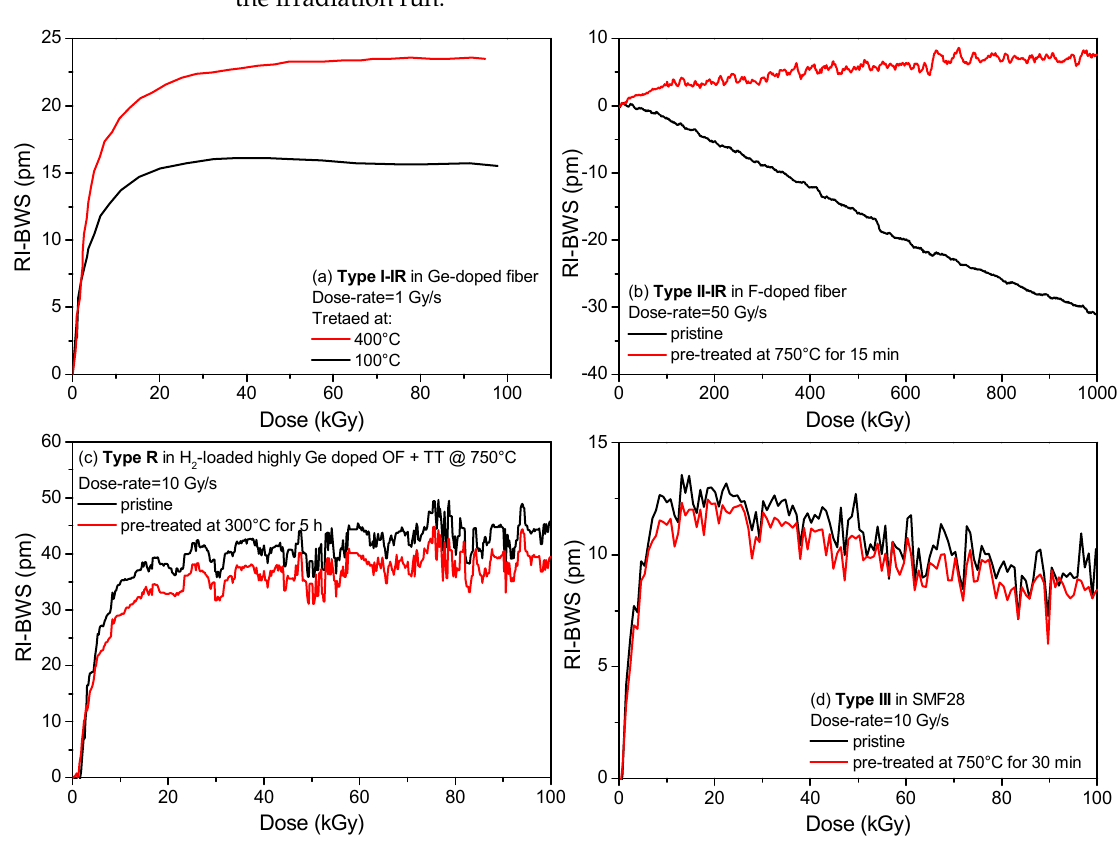
Figure 9. Effect of a pre-thermal treatment on the RI-BWS induced on different FBG types: ( a ) a type I FBG written in a Ge-doped fiber (the Corning SMF28e) with an IR fs-laser (at 800 nm, pulse energy of 1200 µJ); ( b ) a type II FBG in an F-doped fiber with an fs-IR laser (at 800 nm, a pulse width of 150 fs, and pulse energy of ~500 µJ); ( c ) type R FBGs written in H 2 -loaded highly Ge-doped fiber and regenerated at 750 °C; ( d ) a type III in the SMF28 fiber written PbP with an fs-IR laser (at 515 nm, with a pulse width < 290 fs). The gratings reported in ( a ) were investigated under γ -rays, whereas all the others were investigated under X-rays. Data extracted from [84–87].